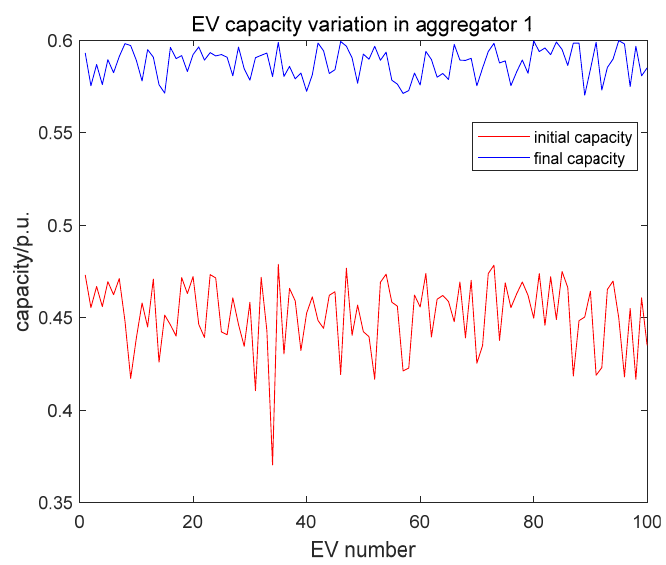
Figure 14. EV capacity variation in aggregator 1.